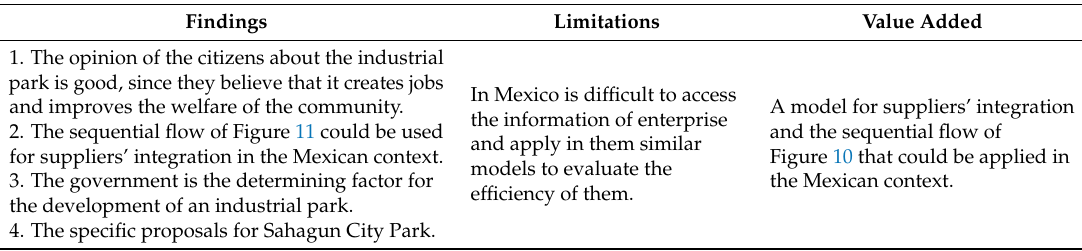
Table 6. Findings, limitations, and value